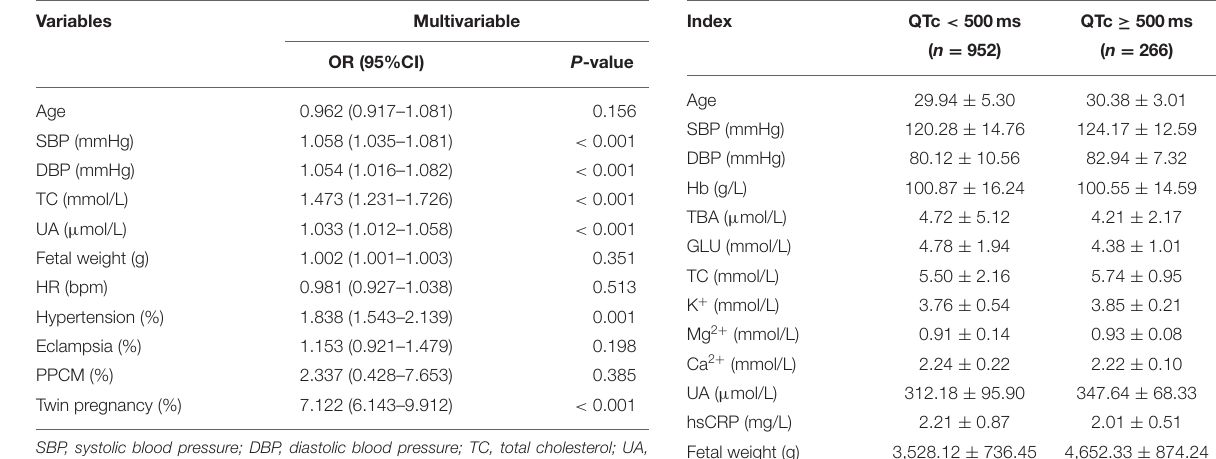
TABLE 5 | Compared of demographic and clinical characteristics between QTc < 500ms and QTc ≥ 500ms